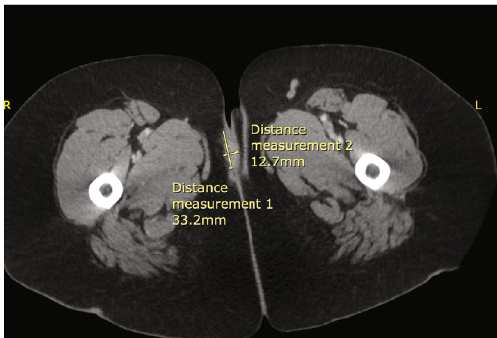
Figure 1: CT scan of the fungating mass with surrounding edema near the right vulvar region, near the groin crease.